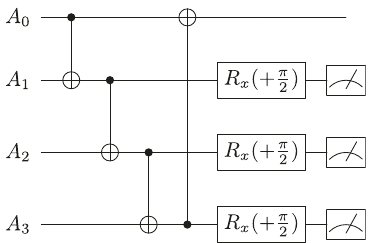
Fig. 4 Circuit of a distillation protocol learned by LOCCNet for isotropic states. This simpli fi ed circuit represents Alice ’ s local operation in a protocol learned by LOCCNet for entanglement distillation with four copies of some isotropic state. Bob ’ s local operation is identical to Alice ’ s, except that the rotation angles of Bob ’ s R x gates are − π